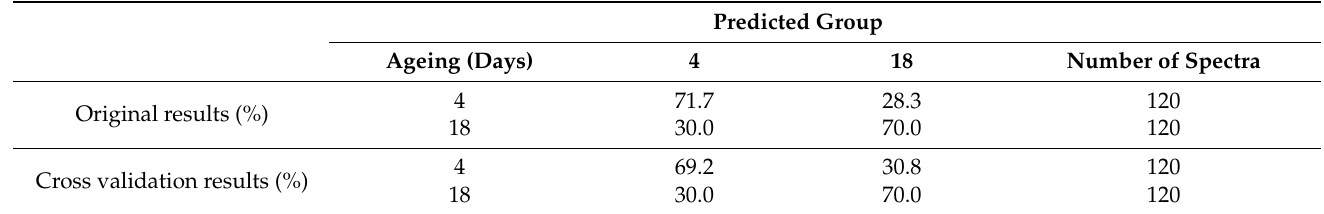
Table 4. Results of the classification of the beef samples in the initial and final ageing days (4 and 18 days) using the spectral information in the range between 1951 and 980 cm − 1 .